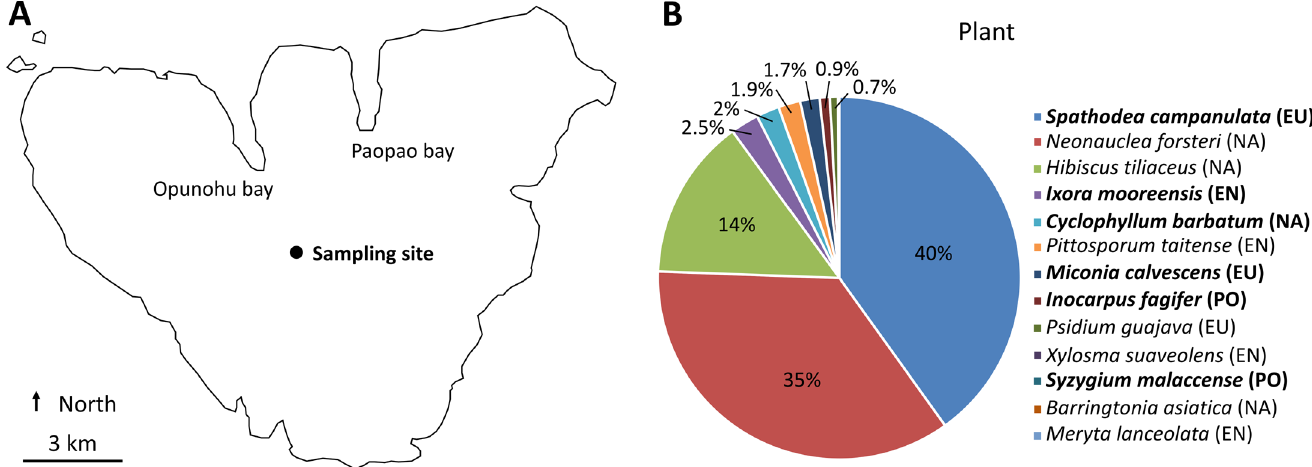
Figure 1. Sampling site in Mo’orea (French Polynesia). ( A ) Location of the sampling site. ( B ) Plant assemblage at the sampling site. The plant species of this study are in bold. EN: endemic; EU: Euro- pean introduction; NA: native; PO: Polynesian introduction. European introduction; NA: native; PO: Polynesian